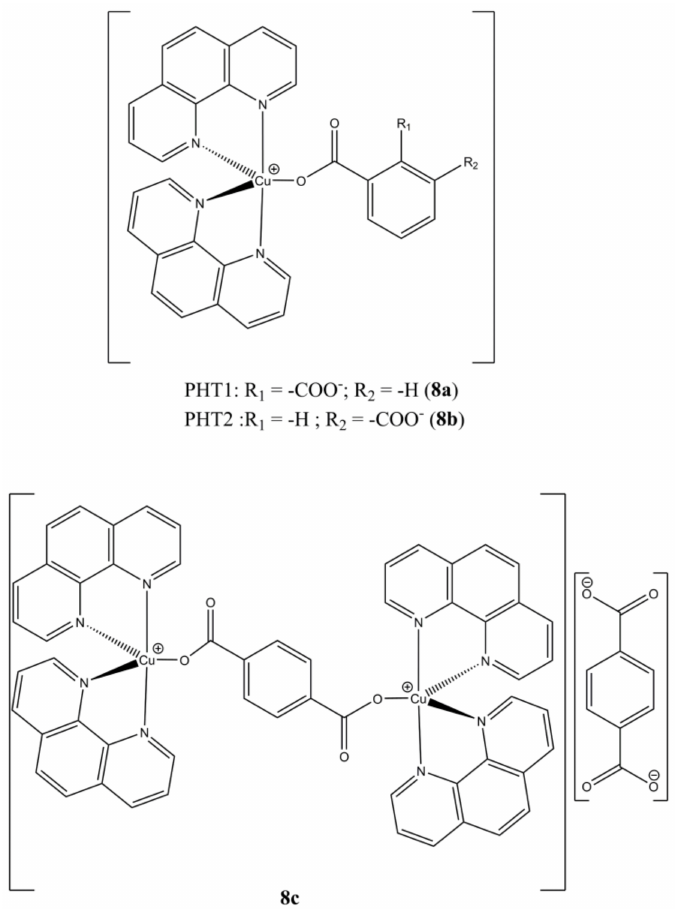
Figure 8. Structures of [Cu(phen) 2 (PHTn)] ( a , b ) and [Cu 2 (phen) 4 ( µ -PHT3)](PHT3) ( c ) complexes. These compounds show higher anticancer potencies (at micromolar level) in breast (MCF-7), prostate (DU145) and colon (HT29) cancer cells compared to the approved